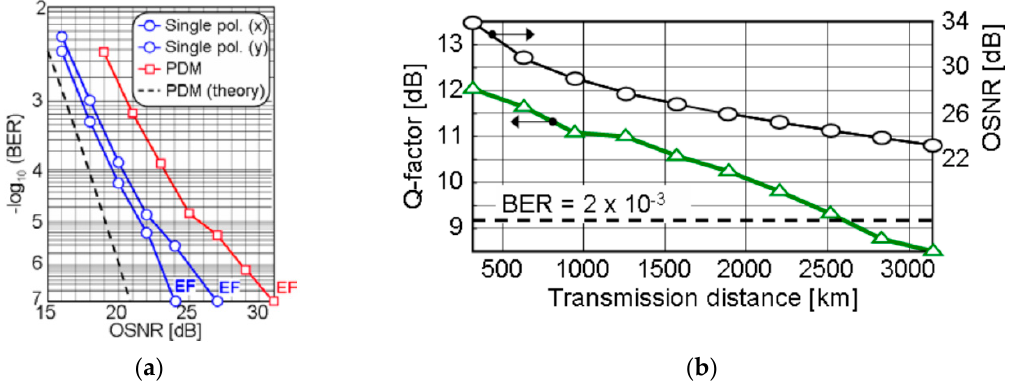
Figure 6. ( a ) B2B BER performance at 56 Gbaud: single polarization 112 Gbit / s quadrature-phase-shift-keying (QPSK) and 224 Gbit / s polarization-division multiplexed (PDM)-QPSK; ( b ) Q-factor and optical signal-to-noise ratio (OSNR) vs. transmission distance.